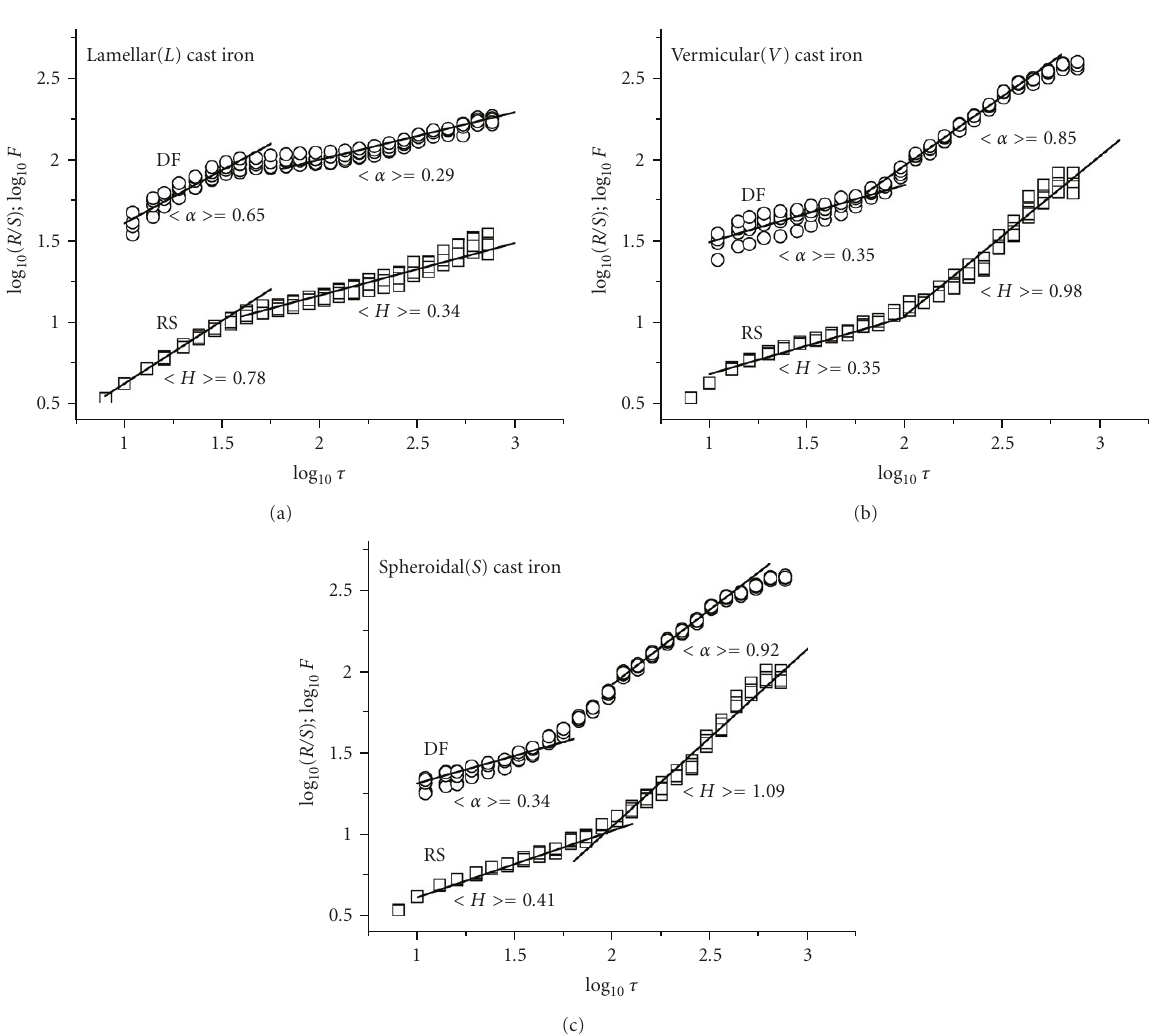
Figure 1: Double-logarithmic plots of the curves obtained from Hurst (R/S) and detrended-fluctuation (DF) analyses of backscattered ultrasonic signals propagating in lamellar (a), vermicular (b), and spheroidal (c) cast iron. The values of (cid:4) α (cid:5) and (cid:4) H (cid:5) are obtained by averaging the slopes of all curves in the corresponding intervals, as shown by the solid